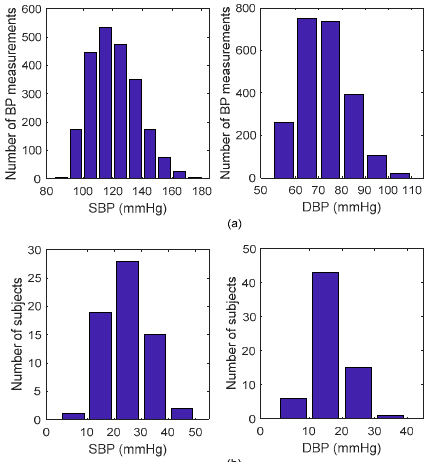
Figure 4. Statistical information of the systolic blood pressure (SBP) and diastolic blood pressure (DBP). ( a ) Statistical distribution. ( b ) Individual dynamic range